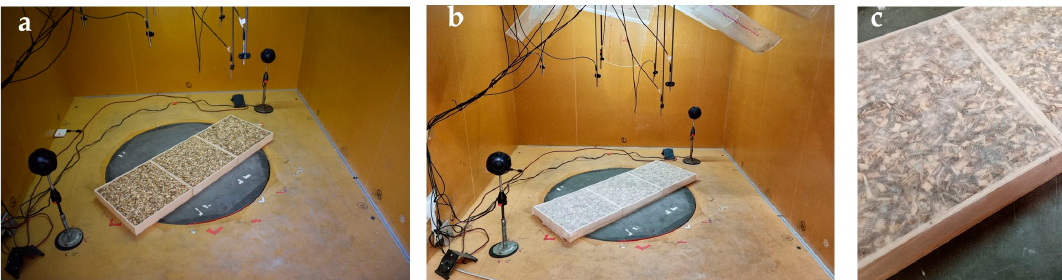
Figure 7. ( a ) O100l full configuration; ( b ) O100l full configuration with TNT; ( c ) details of the TNT.